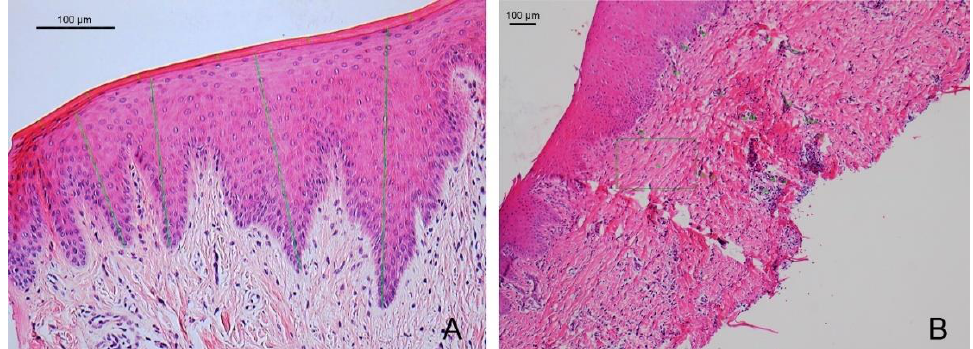
Figure 7. ( A ). Microphotography of the sample treated with an acellular dermal matrix at 45 days (200×). ( B ). Microphotography of the sample treated with subepithelial autogenous connective tissue at 45 days (50×). The distance from the keratin layer to the underlying connective tissue is indicated with green lines.